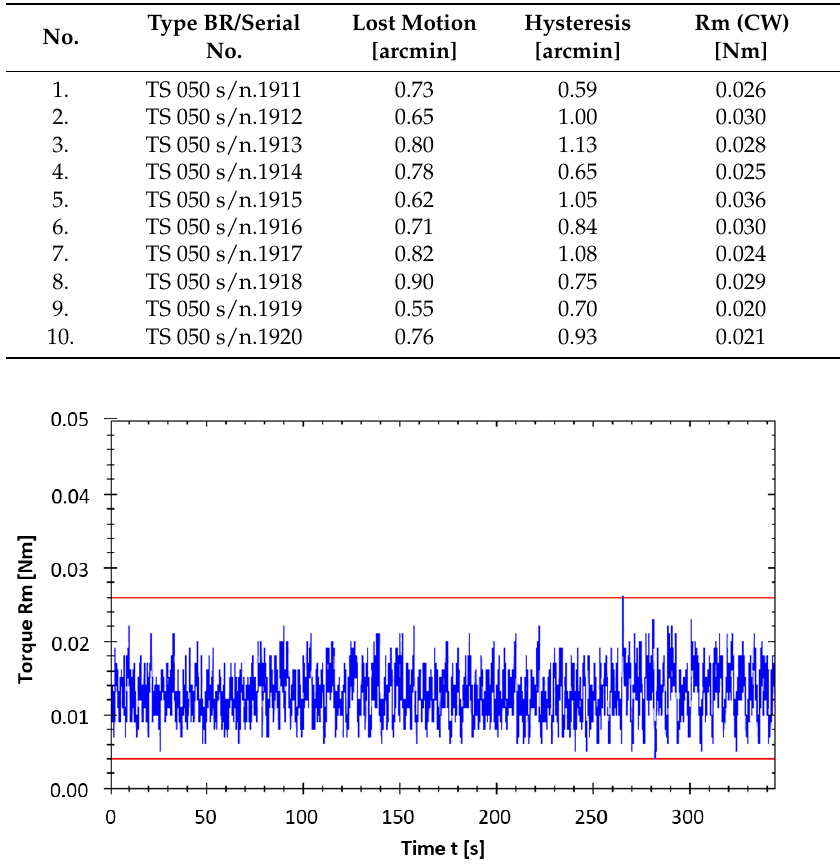
Figure 17. Starting torque (Rm) BR TS 050-63, s/n.1911—CW direction (after the trial run).